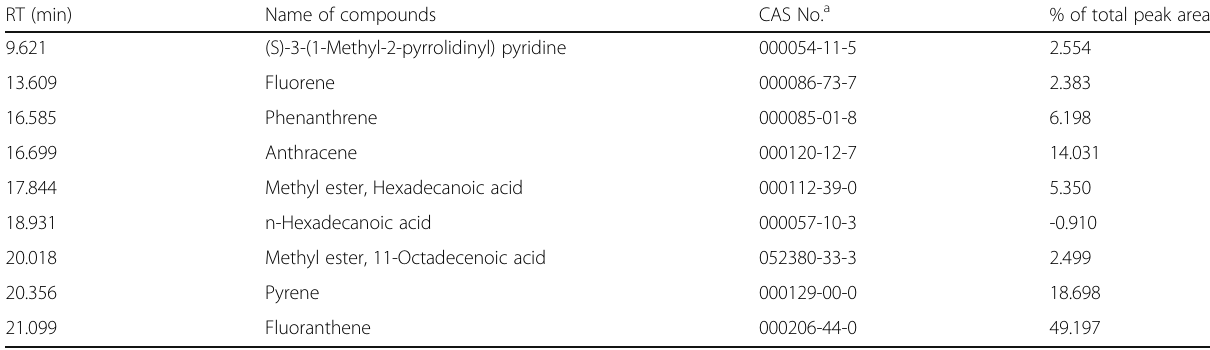
Table 5 Compounds identified in mixture of Nicotiana tabacum plus Jatropha curcas plus Azadirachta indica RT